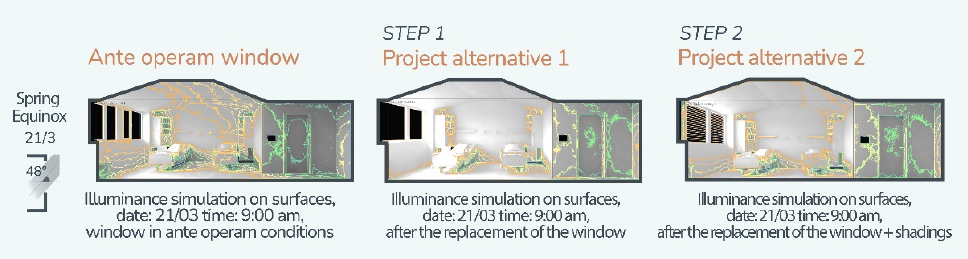
Figure 16. Room 2. Annual analysis of illuminance values on surfaces as a function of window design.